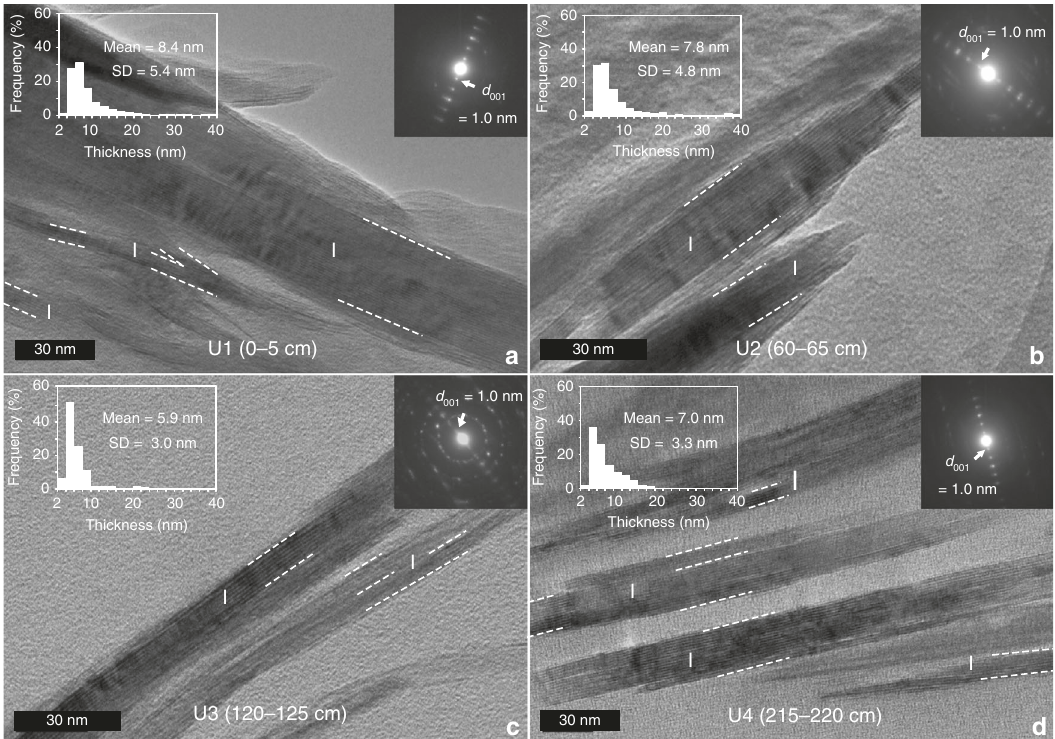
Fig. 3 Transmission electron microscopy micrographs with selected area diffraction patterns and grain-size distribution. Samples with depths of a 0 – 5 cm (U1), b 60 – 65 cm (U2), c 120 – 125 cm (U3), and d 215 – 220 cm (U4) of the core EAP13-GC16B (dashed lines show the boundary of illite (I) packets). The inset histograms of the grain-size distribution of illite (U4 – 1) fl atten, broaden, and shift to larger size with a high standard deviation. The inset selected area electron diffractions of illite ( d 001 = 1.0 nm) shows modi fi cation of illite structure of randomly ordered/diffused Bragg ’ s re fl ections (U3) to discrete ordered pattern (U1).